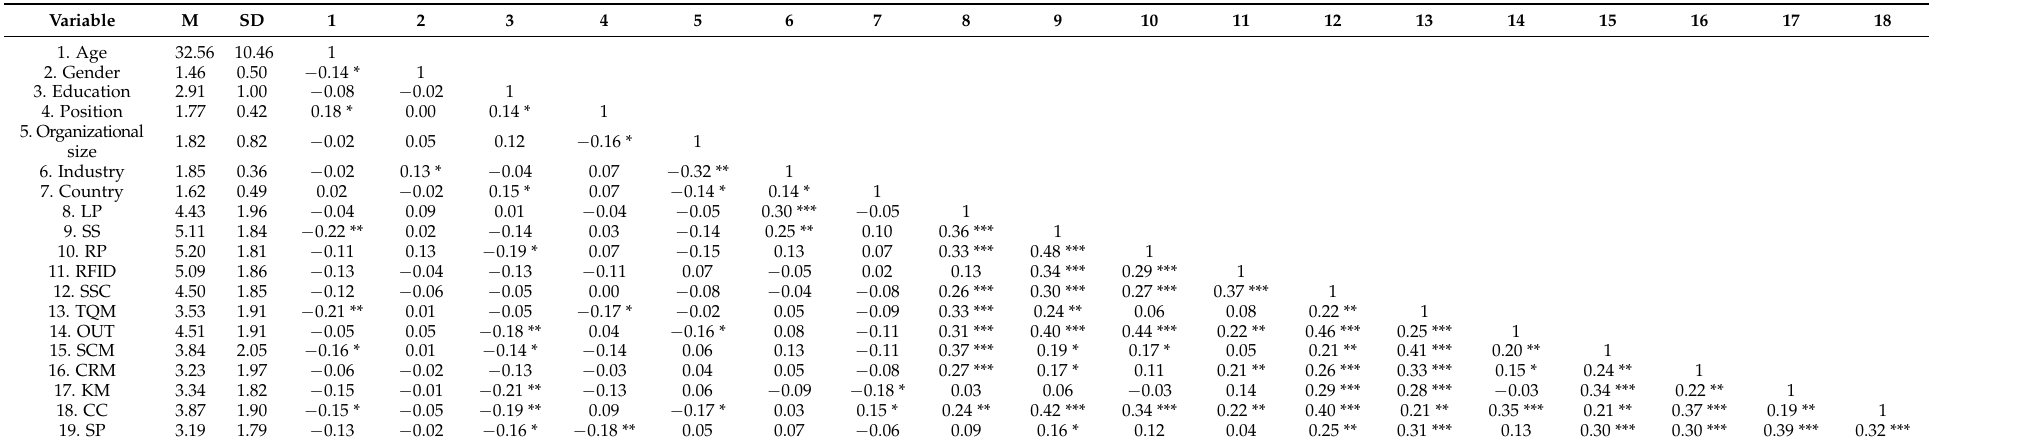
Table 2. Means, standard deviations, and correlations a